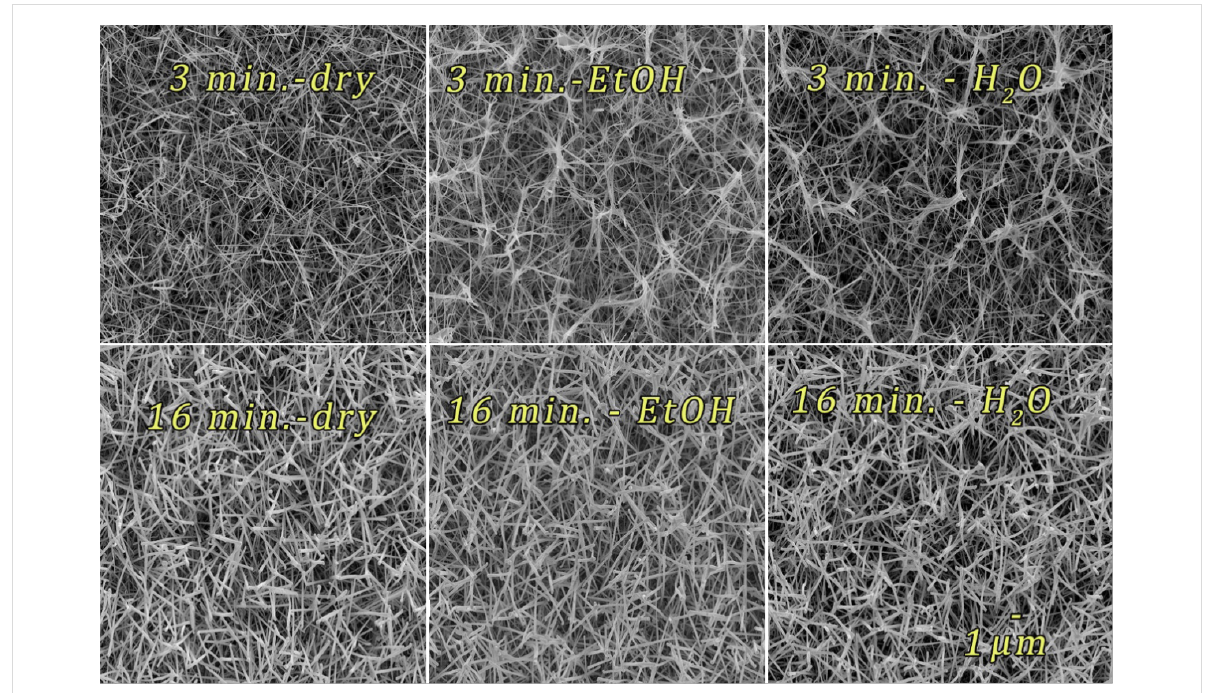
Figure 4: SEM images of dry samples in comparison with the one after immersion in EtOH and water for two different sputtering times of 3 and 16 min.